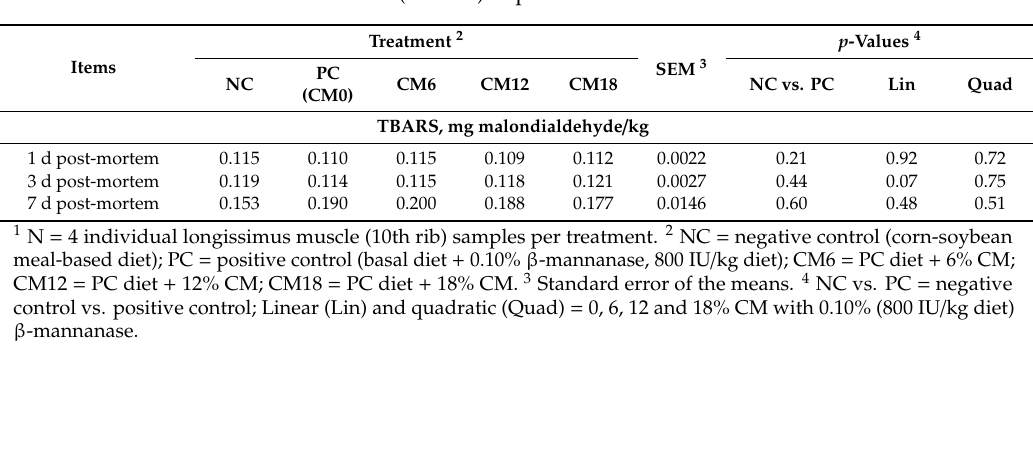
Table 8. E ff ects of copra meal (CM) inclusion level in the diet with β -mannanase on concentrations of thiobarbituric acid reactive substances (TBARS) in pork loin 1